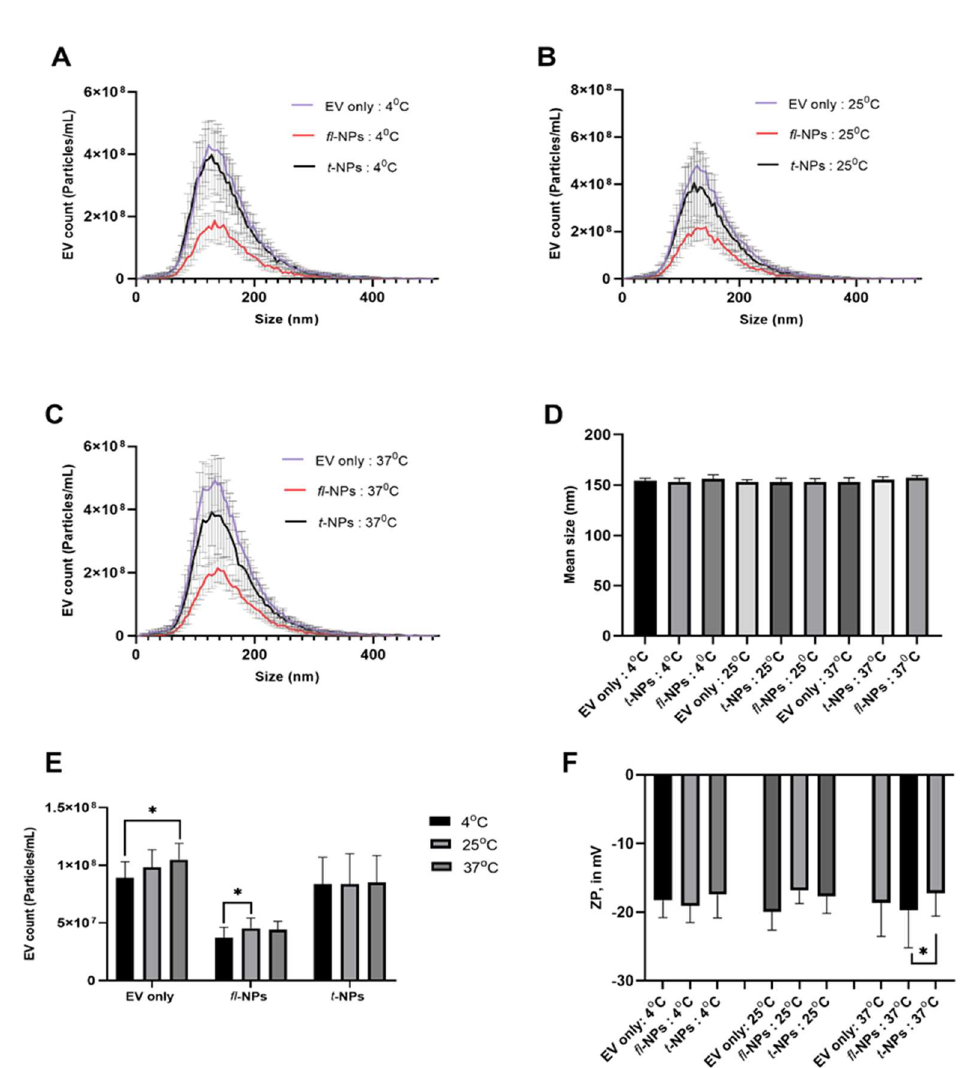
Figure 7. The size distribution, concentration, and zeta potential of fluorescent and total NPs originating from JAr cells incubated at three different temperatures. Size distribution ( A – C ), means particle size ( D ), particle concentration ( E ), and zeta potential ( F ) of EVs incubated at 4, 25, and 37 °C. EV only controls, fl -, and t- NPs of JAr EVs were measured in fluorescent and scatter modes of NTA. EVs were labeled with 100 ng/mL of CMG and fl -NPs were measured at a minimum brightness threshold value of 25. The concentration of fl -NPs of JAr EVs incubated at 4 °C was significantly different ( p ≤ 0.05) than the fl -NPs of JAr EVs incubated at 25 °C. Thus, were marked with an asterisk (*) symbol. EVs were diluted in 1× PBS, and the ZP measurement was done at a neutral pH of 7.2 (mean ± SD, n = 9).